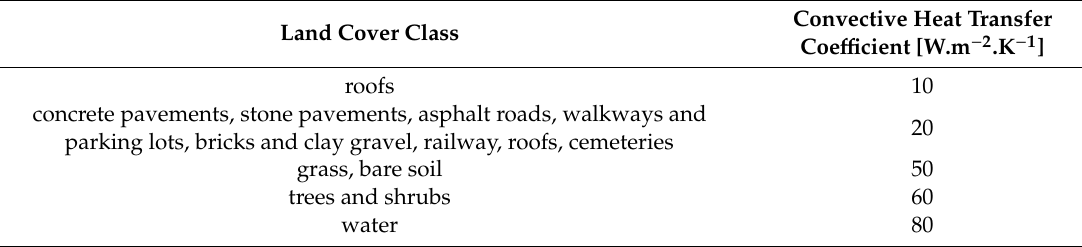
Table 1. Convective heat transfer coe ffi cient ( h c ) values estimated for 25 June 2020 based on land cover classes and meteorological